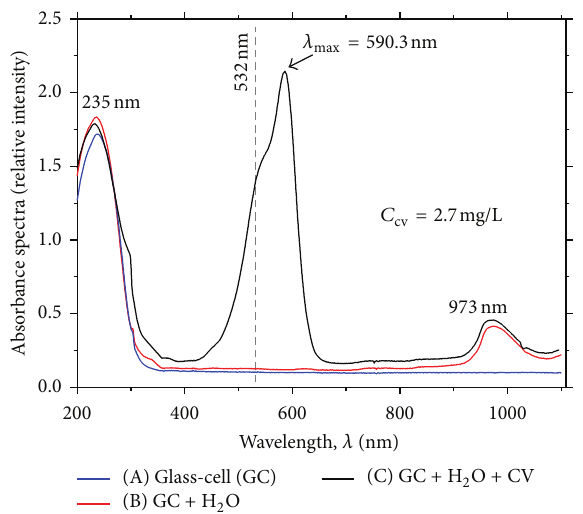
Figure 2: Comparative UV-Vis-NIR absorbance spectra obtained from (A) the empty glass-cell (GC), (B) the reference GC/H 2 O system, and (C) the studied GC/CV/H 2 O dissolution. The CV chromophore exhibits a strong and characteristic absorbance band within the visible spectral range (near the laser excitation wave- = 532 nm: dashed length at 𝜆 ex